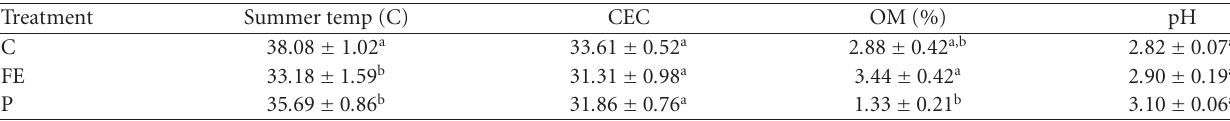
Table 1: Comparison among habitat types (C = center, FE = forest edge, P = pine plots) of the following soil characteristics: cation exchange capacity (CEC), percent organic matter (OM), pH, and summer temperature (C). Values are expressed as means ± 1 SE. Means sharing common letters do not significantly di ff er at α = 0 . 05 to Tukey’s HSD. Analyses based on data transformed by square root.